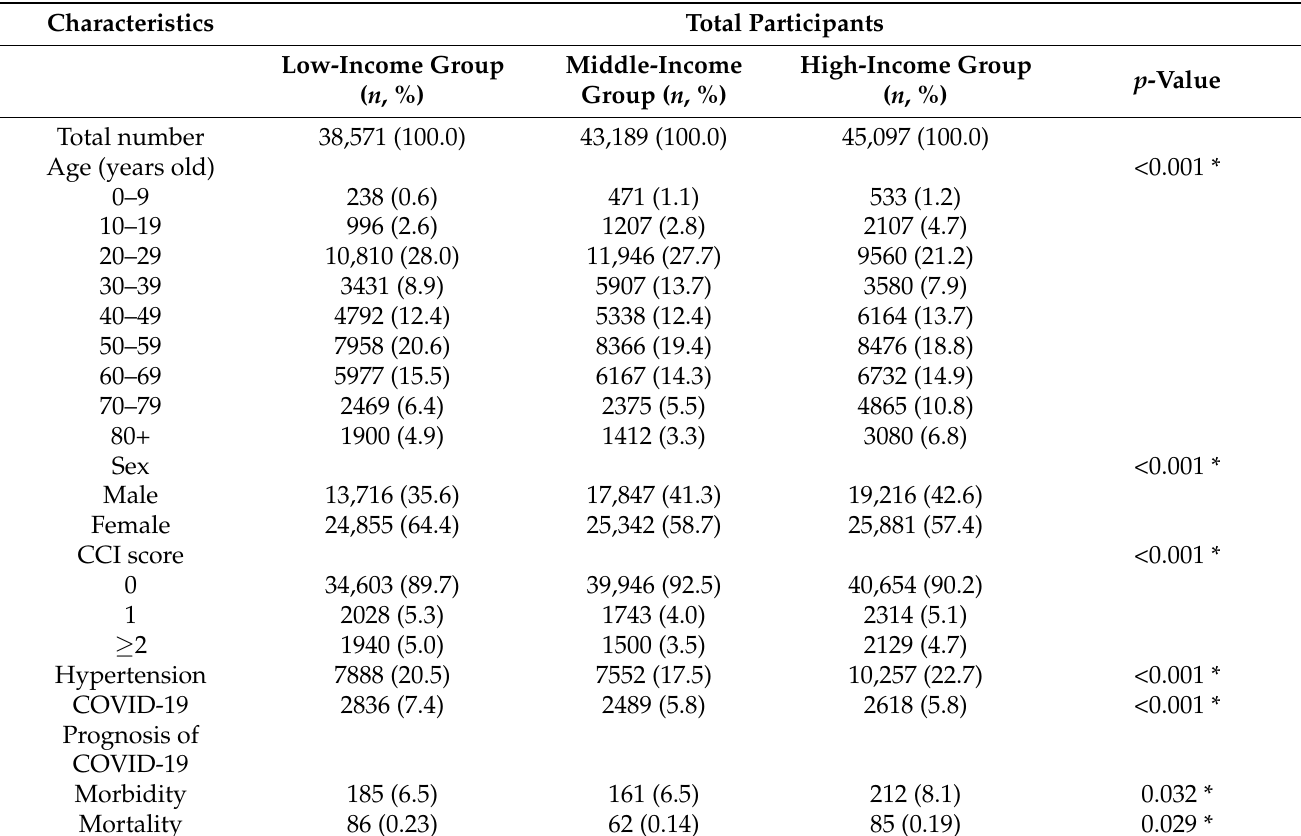
Table 1. General characteristics of the participants.